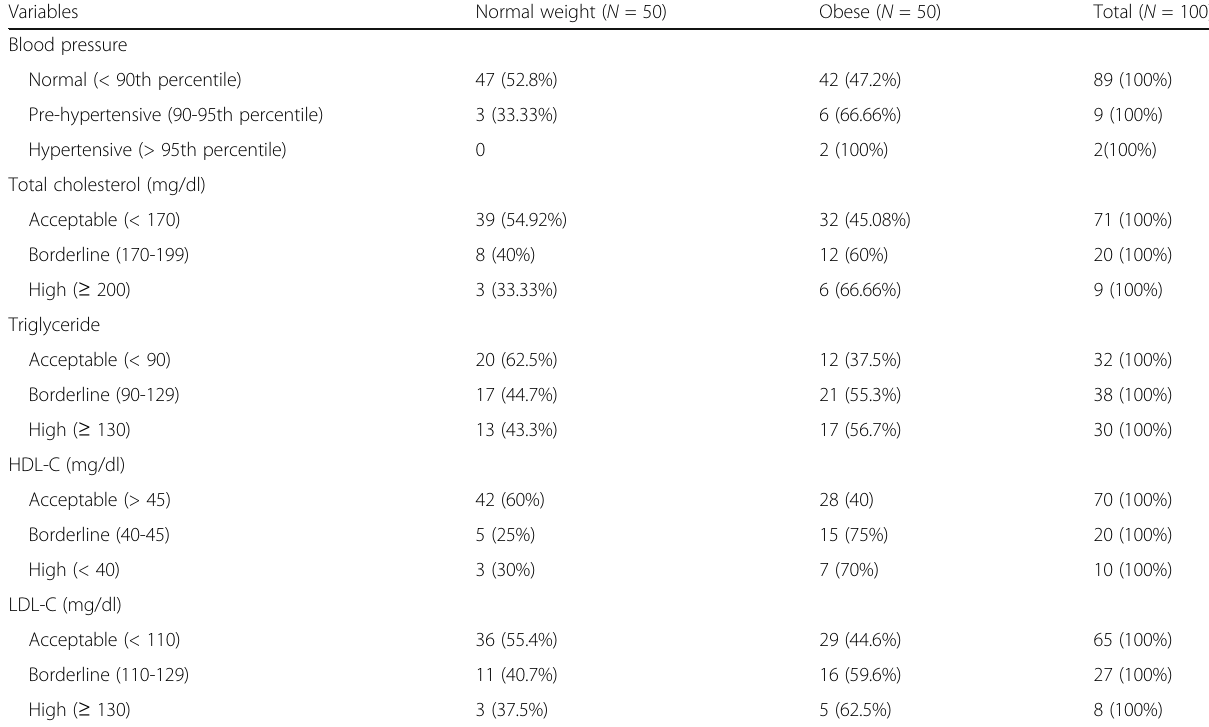
Table 3 Sample distribution by lipid profile and blood pressure in normal weight and obese children Variables